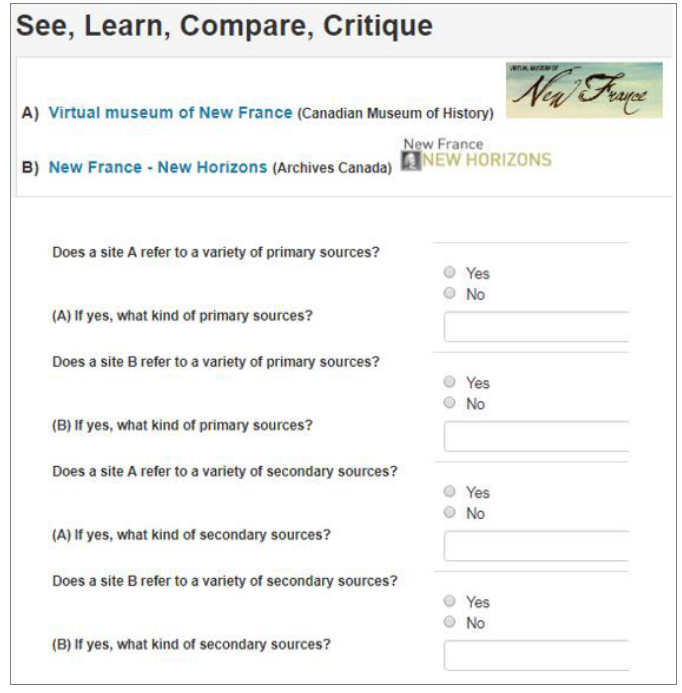
Figure 1. A selection of questions posed in the “see, learn, compare, critique” assignment.